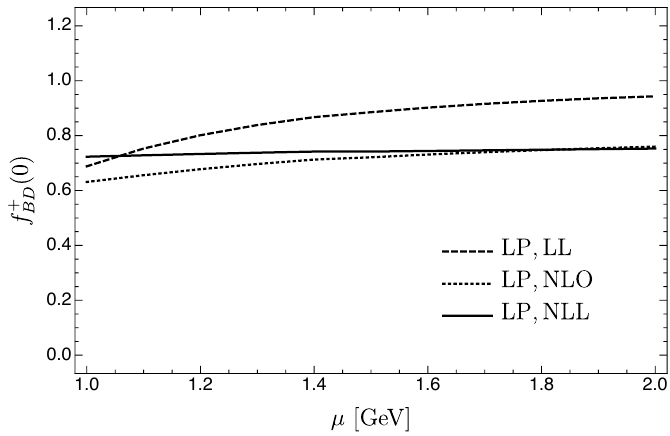
( q 2 = 0) at leading power Figure 3 . Factorization scale µ dependence of the form factor f + BD approximation. An explanation for the nomenclature is in order: “LL”, “NLO”, and “NLL” correspond to C 0 is the i -loop matching coefficient ⊗ Φ 1 , C 1 ⊗ Φ 0 , and C 1 ⊗ Φ 1 , respectively, where C i 1 1 2 j including up to j -loop anomalous dimension (scale dependence) whereas Φ denotes the twist-3 i LCDA with i -loop evolution improvement. The symbol ⊗ stands for a general convolution